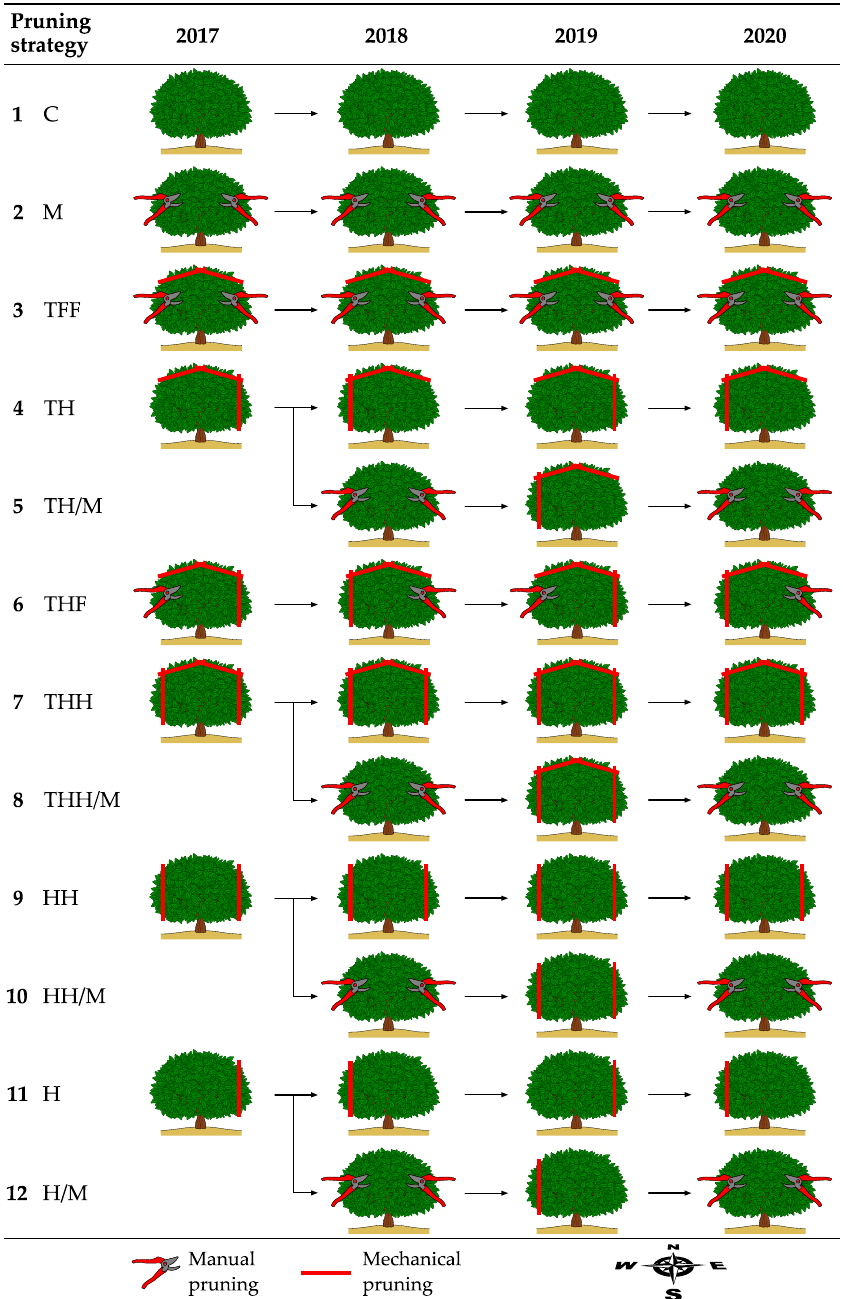
Figure 1. Intervention sequences by pruning strategy and year. Legend: 1 C = control (no pruning); 2 M = manual pruning; 3 TFF = topping and manual follow-up pruning of a complete tree; 4 TH = topping and one-sided hedging, alternating annually between sides (East/West); 5 TH/M = alternating annually between TH and M; 6 THF = TH plus manual follow-up pruning of the non-hedged side; 7 THH = topping and bilateral hedging; 8 THH/M = alternating annually between THH and M; 9 HH = bilateral hedging; 10 HH/M = alternating annually between HH and M; 11 H = one-sided hedging, alternating annually between sides (East/West); 12 H/M = alternating annually between H and M.